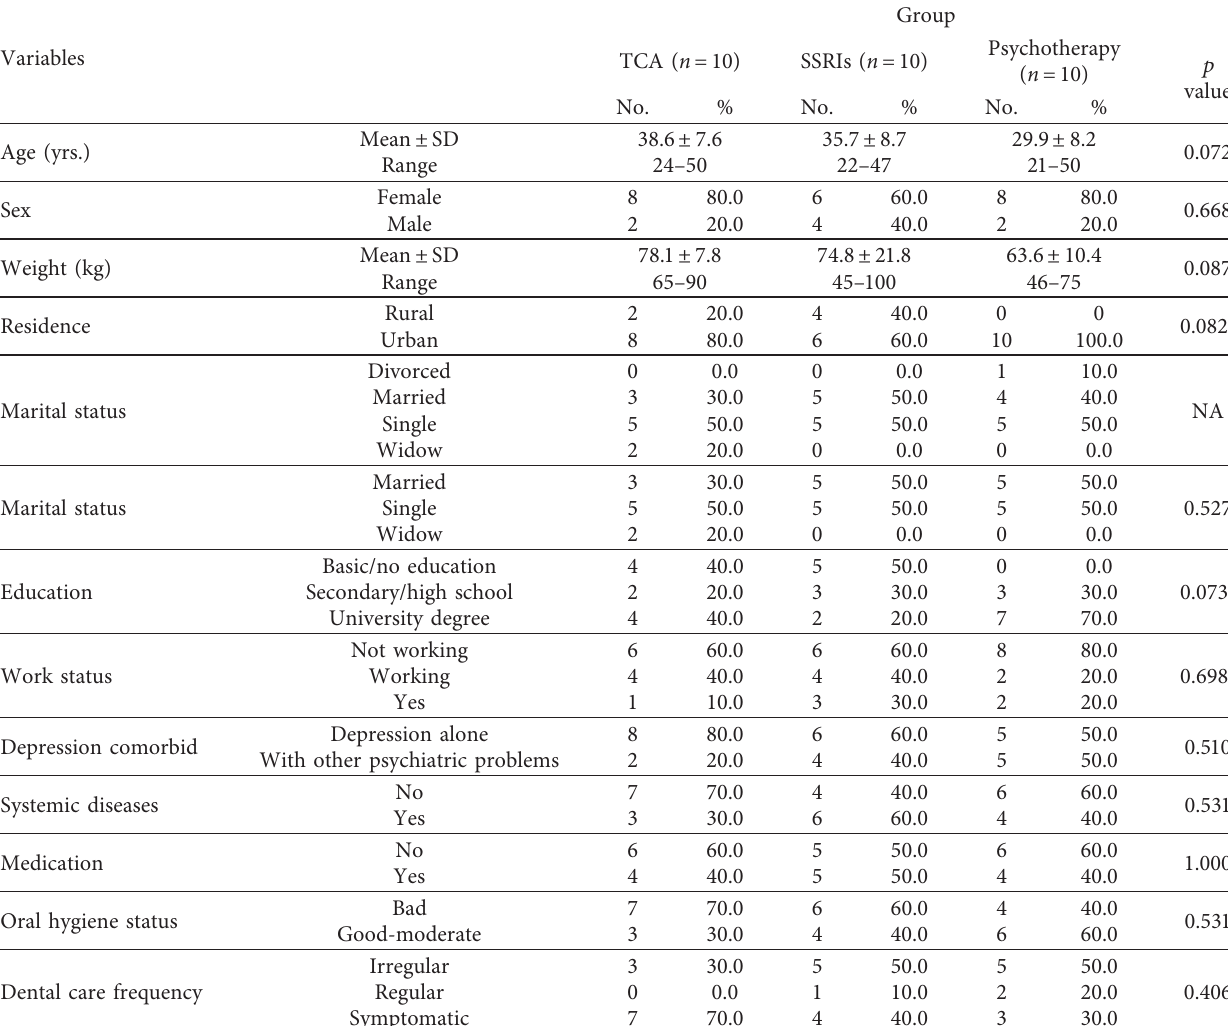
Table 1: Descriptive statistics, one-way ANOVA, Chi square tests, and fisher’s exact test for the demographic data and other variables of the tested groups.